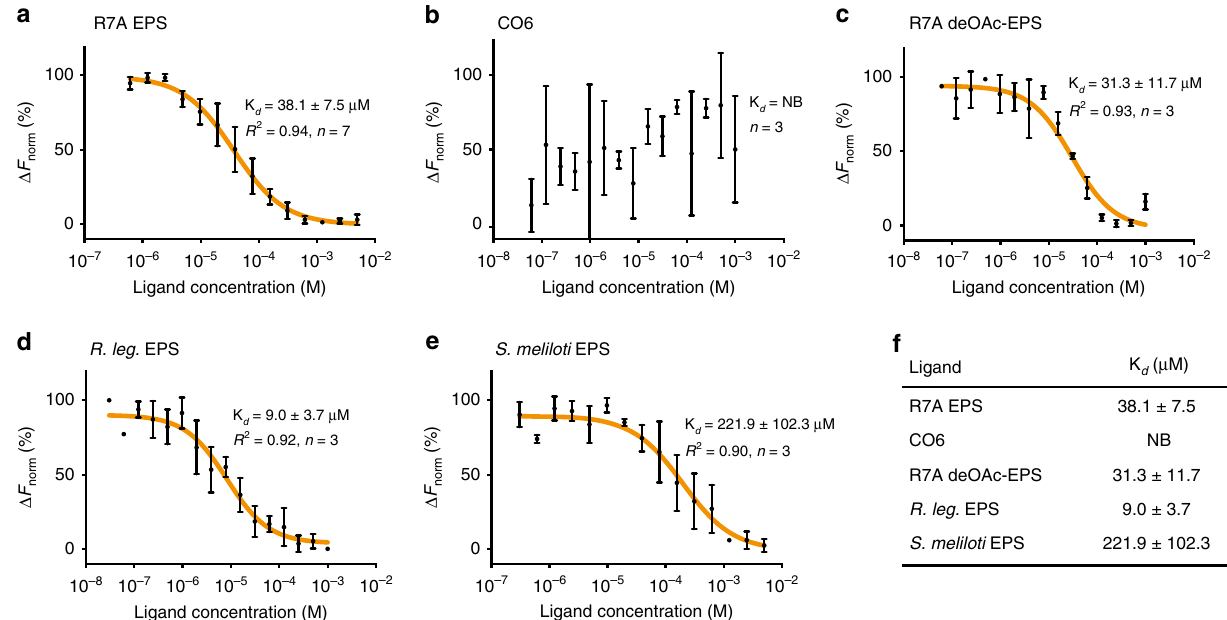
Fig. 4 Lotus EPR3 is a promiscuous EPS receptor. a EPR3 binds R7A EPS with a K d of 38.1 ± 7.5 μ M ( n = 7). b EPR3 does not bind chitin (CO6) ( n = 3). c EPR3 binds R7A de- O -acetylated EPS (deOAc-EPS) with a K d of 31.3 ± 11.7 μ M ( n = 3). d EPR3 binds R. leguminosarum ( R. leg .) EPS with a K d of 9.0 ± 3.7 μ M ( n = 3) and e S. meliloti EPS with a K d of 221.9 ± 102.3 μ M ( n = 3). f Overview of the equilibrium-dissociation constants value (K d ) in the 95% con fi dence interval for the different ligands. The corresponding goodness of fi t ( R 2 ) are indicated, and ( n ) represents the number of replicates performed using independent protein preparations. NB no detectable